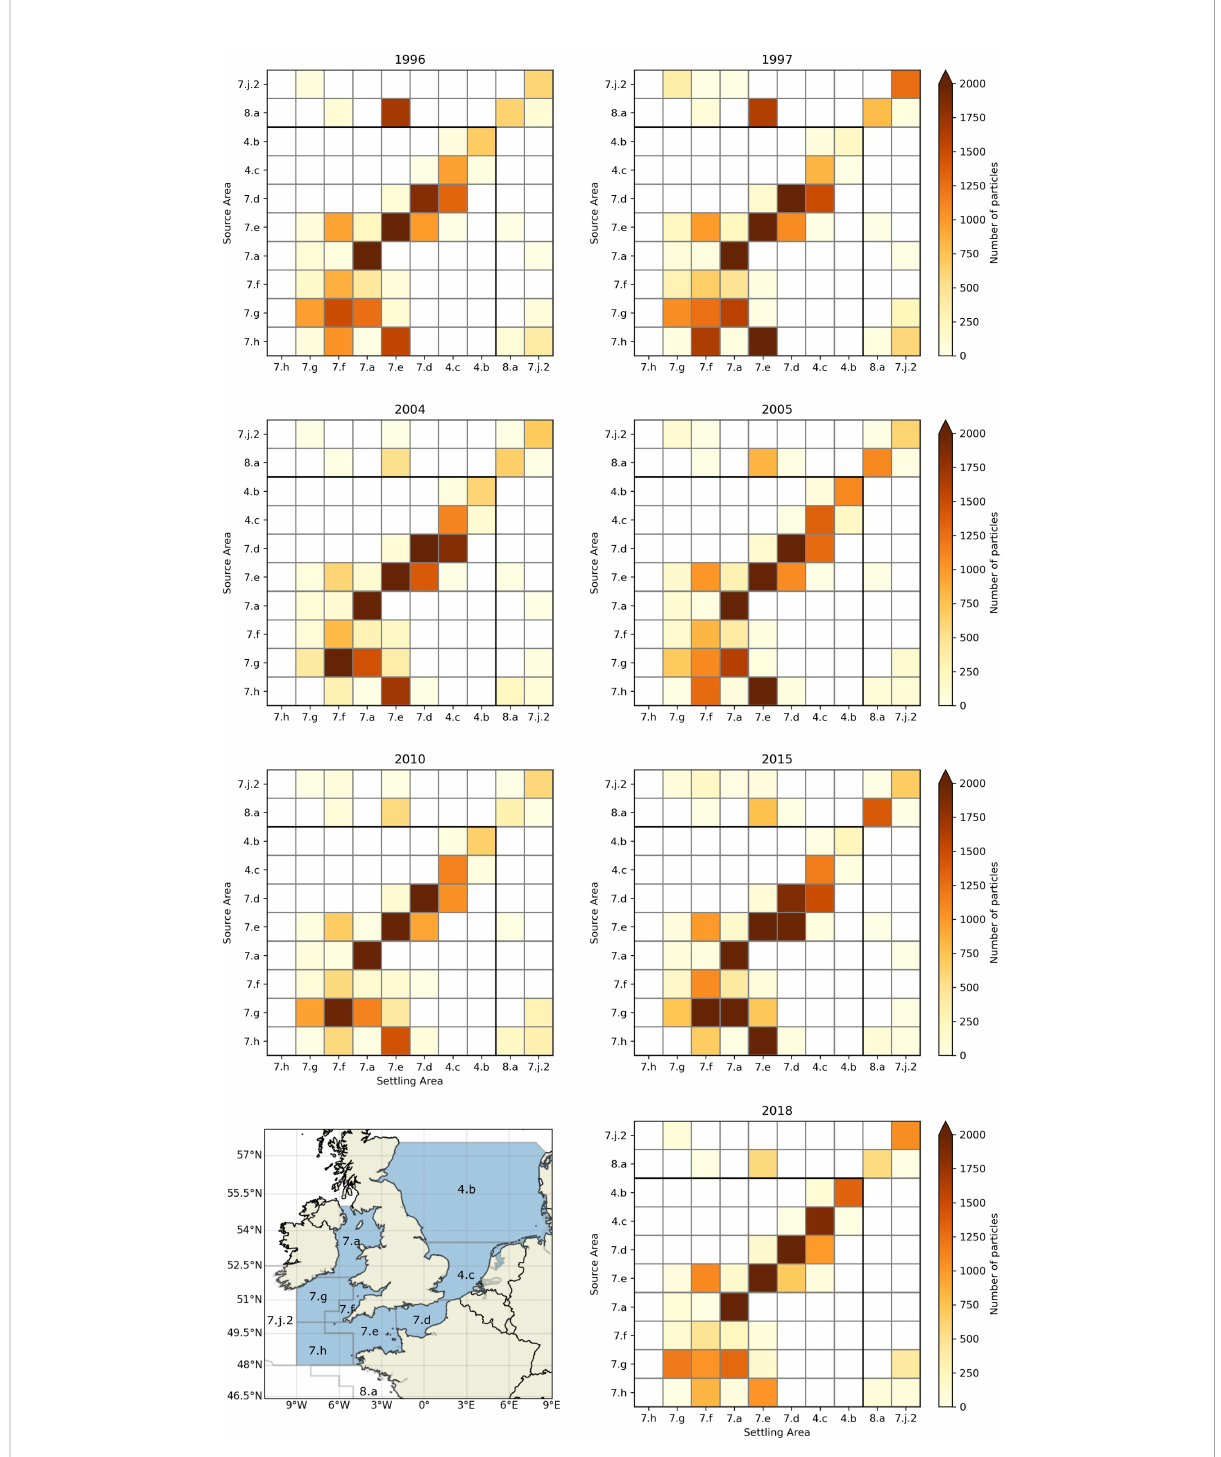
FIGURE 9 Connectivity matrix, showing number of particles sourced and settled within ICES areas for the northern stock (7.a, d-h, 4.b-c), bounded by black lines, and adjacent areas of interest (8.a and 7.j.2). Location of each area is shown in lower left panel. Values along the diagonal indicate spawning and settling within the same area. White boxes indicate zero particles